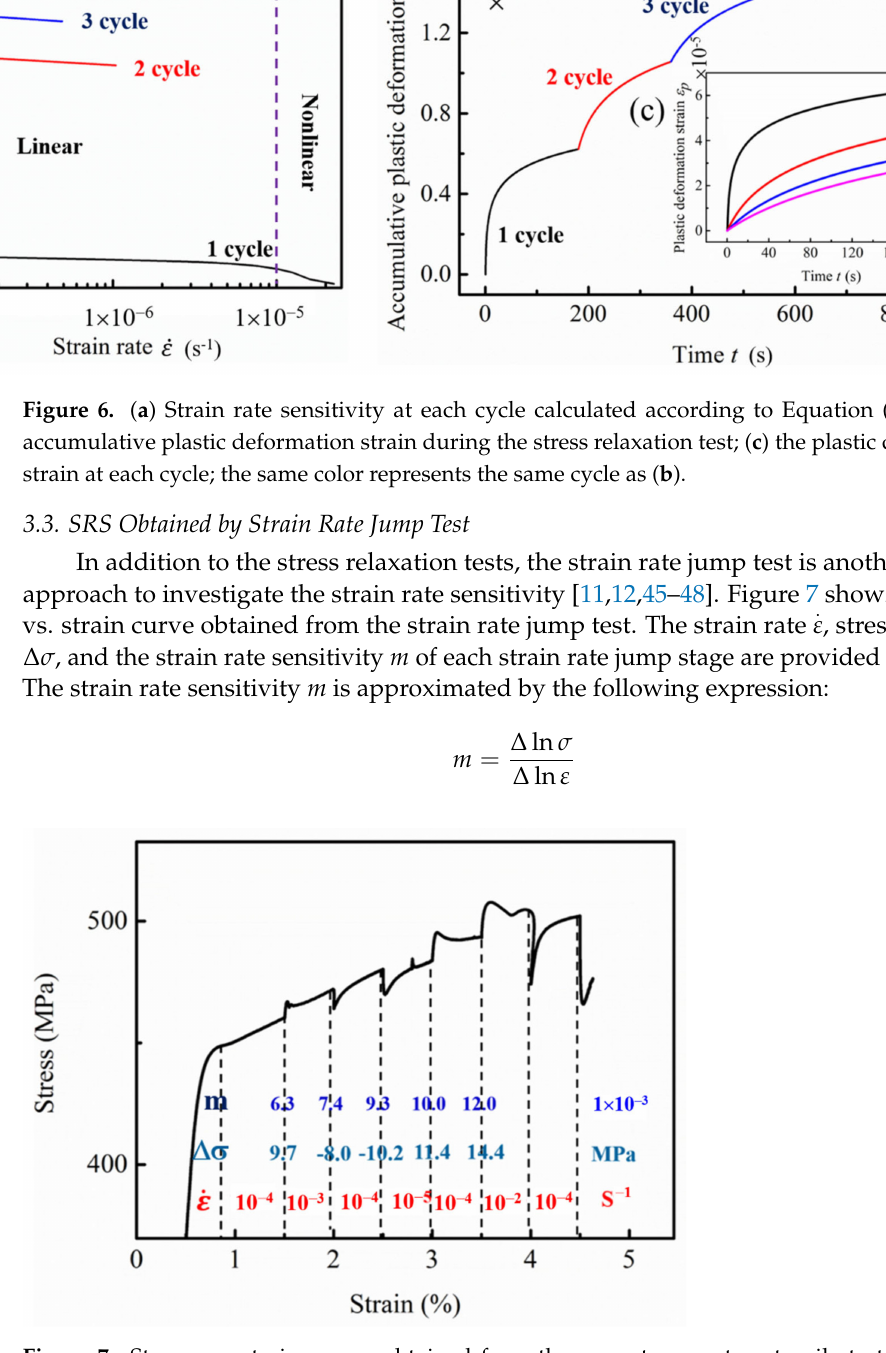
Figure 7. Stress vs. strain curves obtained from the room temperature tensile test with strain rate